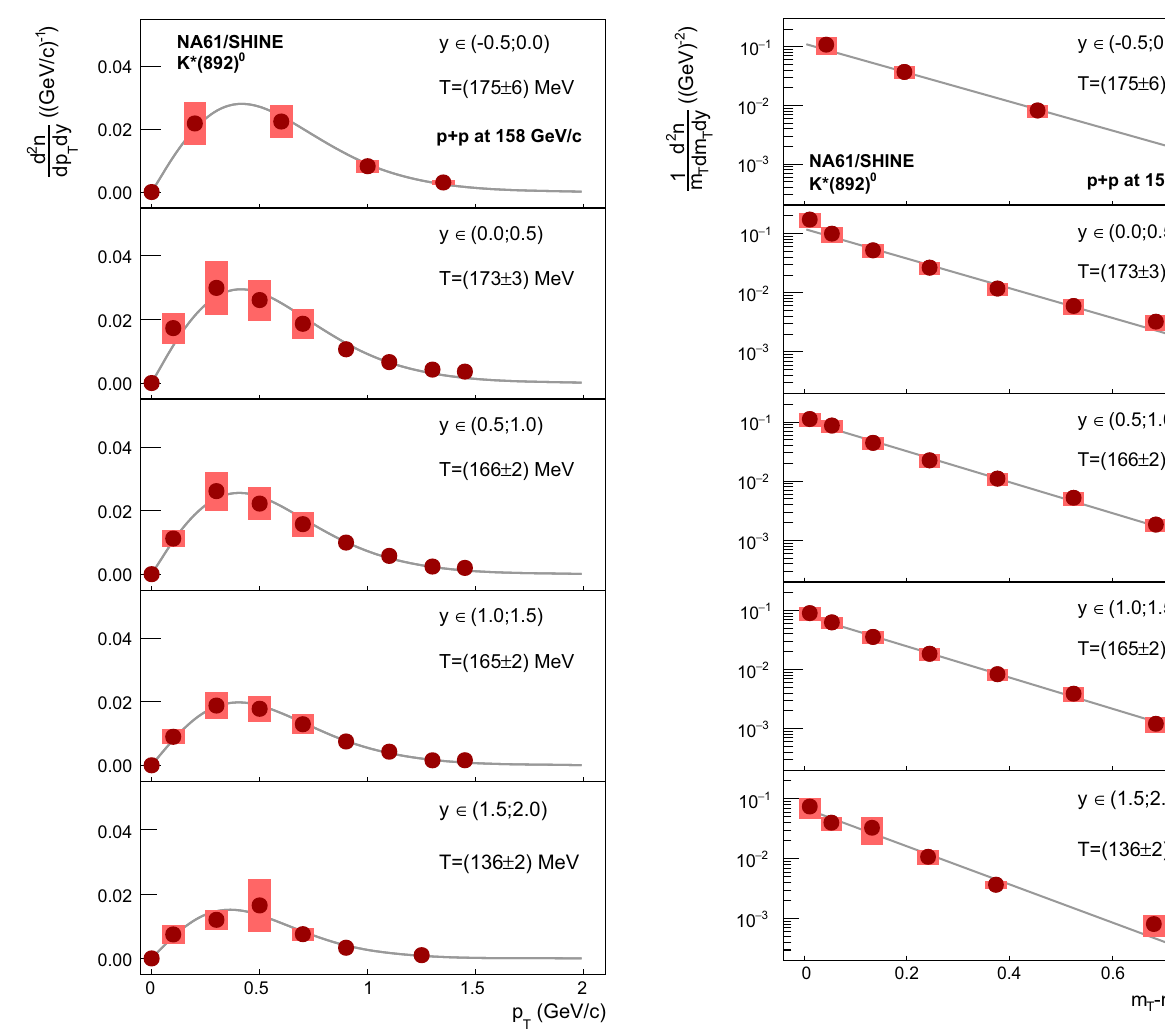
Fig. 10 Transverse momentum spectra d 2 n Thefittedfunction(solidline)isgivenbyEq.(12).Thenumericalvalues are listed in Table 3 and the fitted inverse slope parameters T for each bin are given in the legends